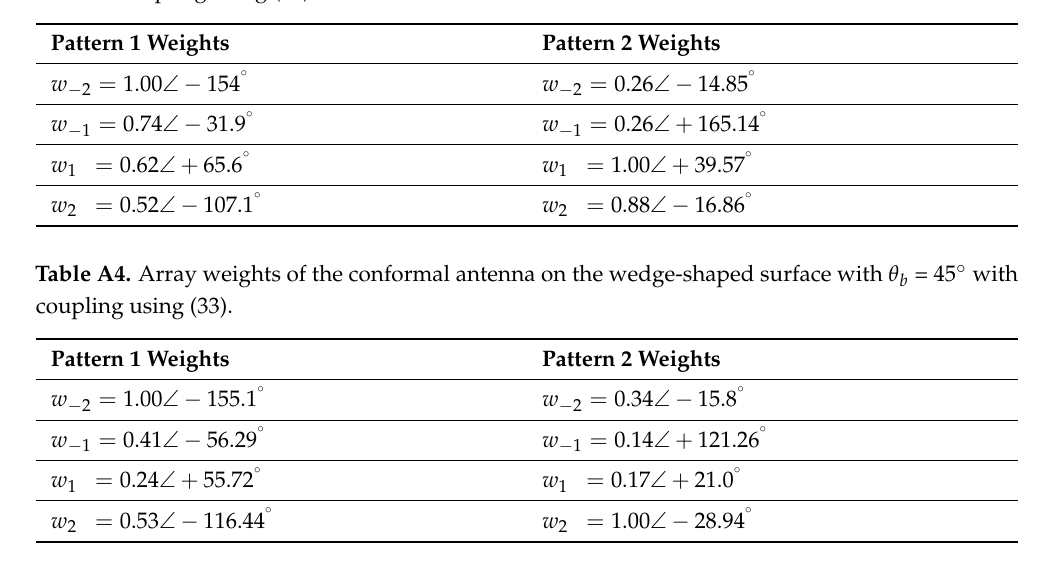
Table A3. Array weights of the conformal antenna on the wedge-shaped surface with θ b = 45 ◦ without coupling using (19).